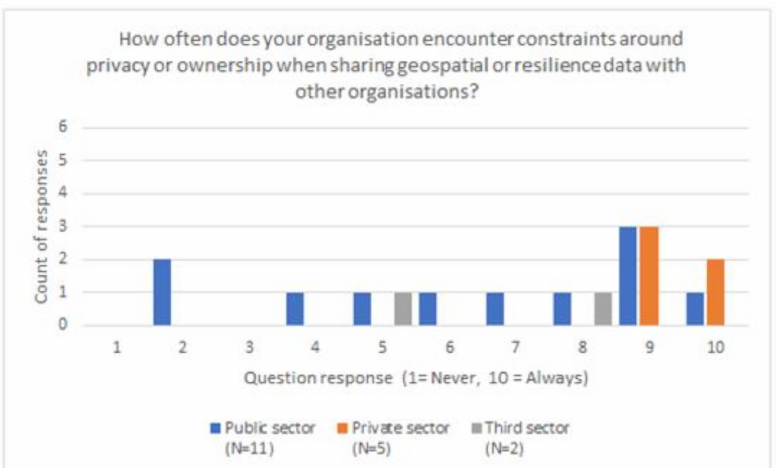
Figure 6. Number of responses per sector obtained for the following survey question: “How often does your organisation encounter constraints around privacy or ownership when sharing geospatial or resilience data with other